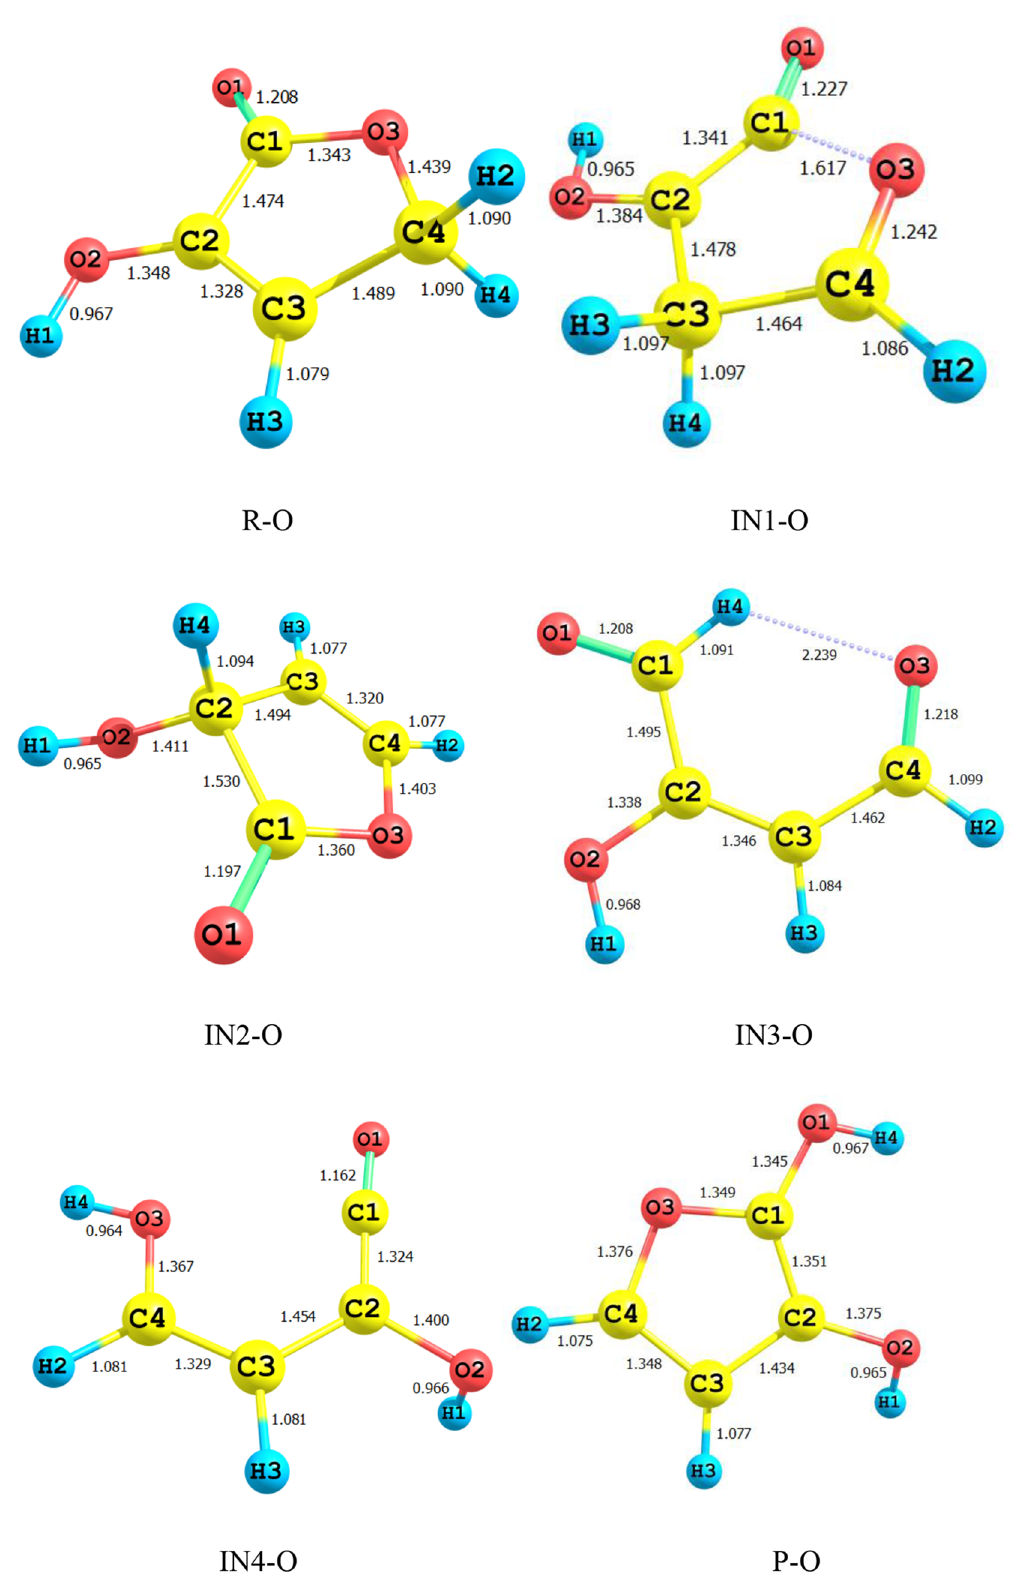
Figure 4. Lowest structures of all stationary points in 3-hydroxyfuran-2(5H)-one unimolecular reaction obtained at the M06-2X/Jun-cc-pVTZ